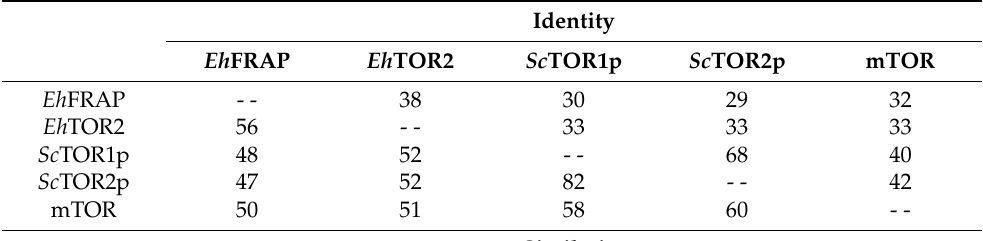
Table 2. Pairwise comparisons of TOR-like amoebic proteins with yeast and mammalian counterparts. Percentage values of identity and similarity (global alignments).